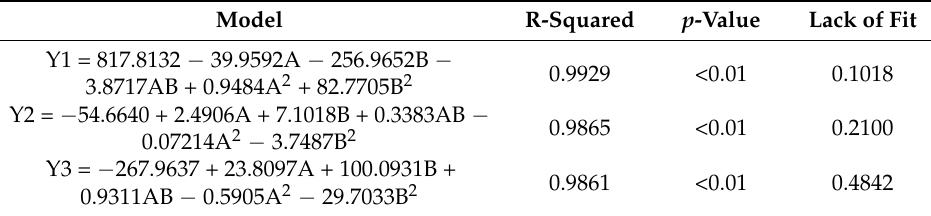
Table 3. Regression model fitting and ANOVA results for each